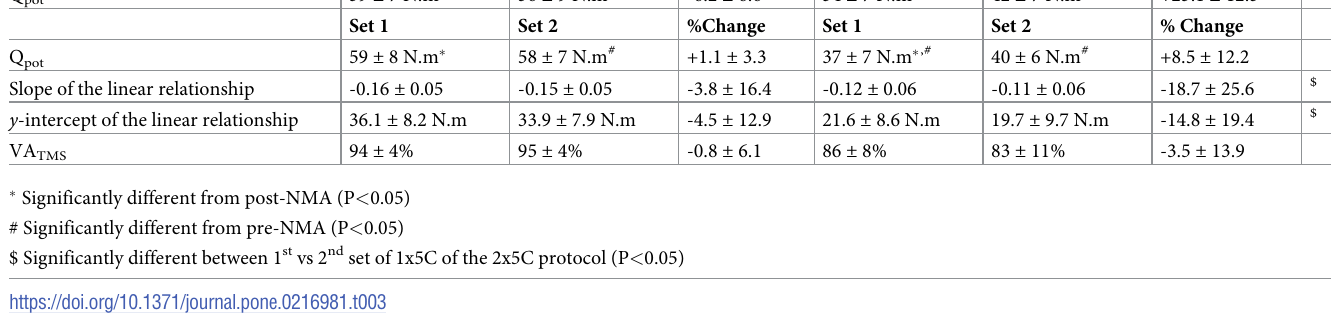
Table 3. Means, standard deviations, and percent changes in key measures of the neuromuscular function before, during, and after the 5C protocol. Pre-exercise